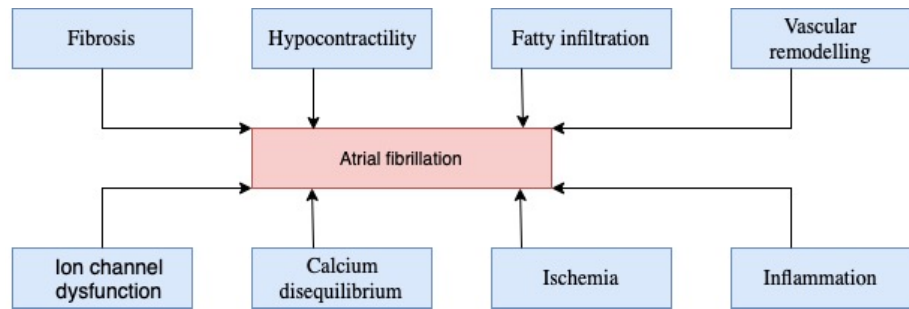
Figure 1. Contributing factors to atrial fibrillation.